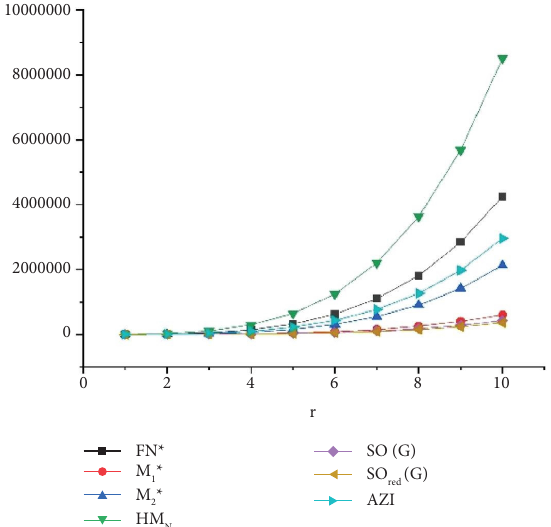
Figure 8: Te correlation of r and AZI.